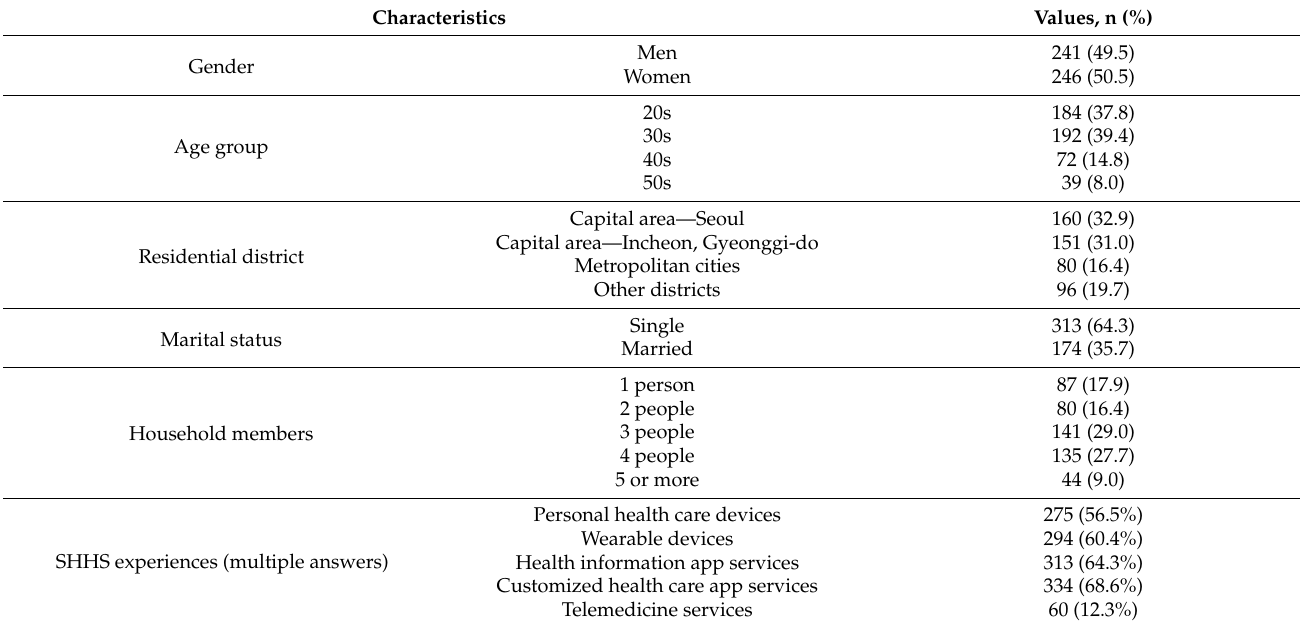
Table 3. Participants’ demographic